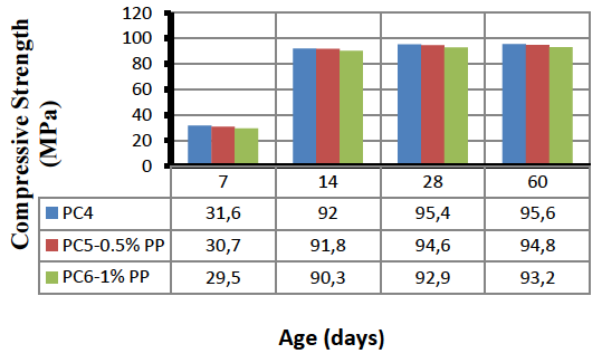
Figure 3: Influence of Polypropylene Fibers on Compressive Strength of Polymer Concrete with